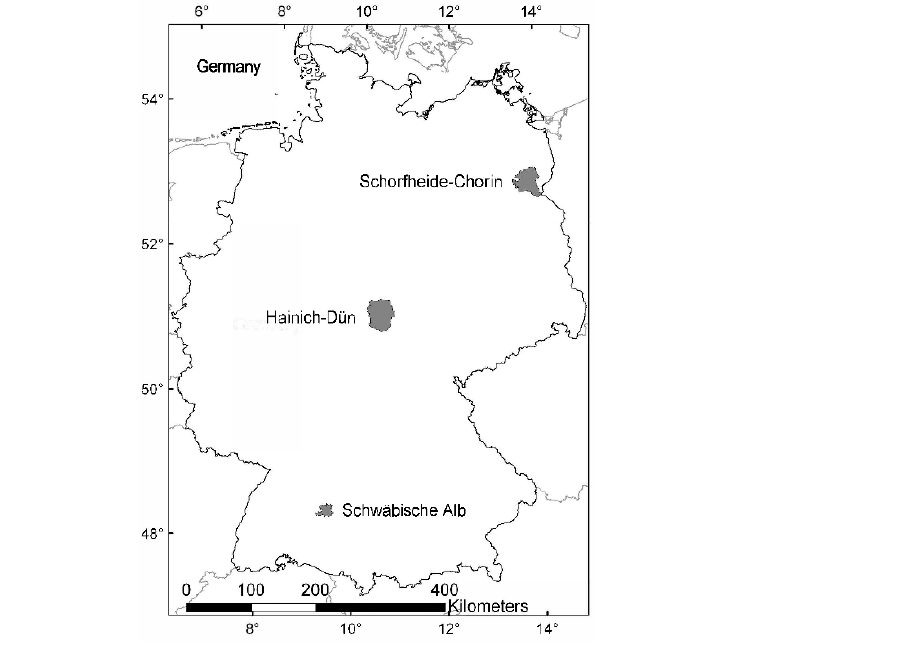
Figure 2. Location of the three study regions in Germany: Schorfheide-Chorin (northeast), Hainich-Dün (center) and Schwäbische Alb (southwest). Table 1. Main geographic, climatic and habitat characteristics of the three study regions, as well as mean, minimum and maximum values of the analyzed variables by region.